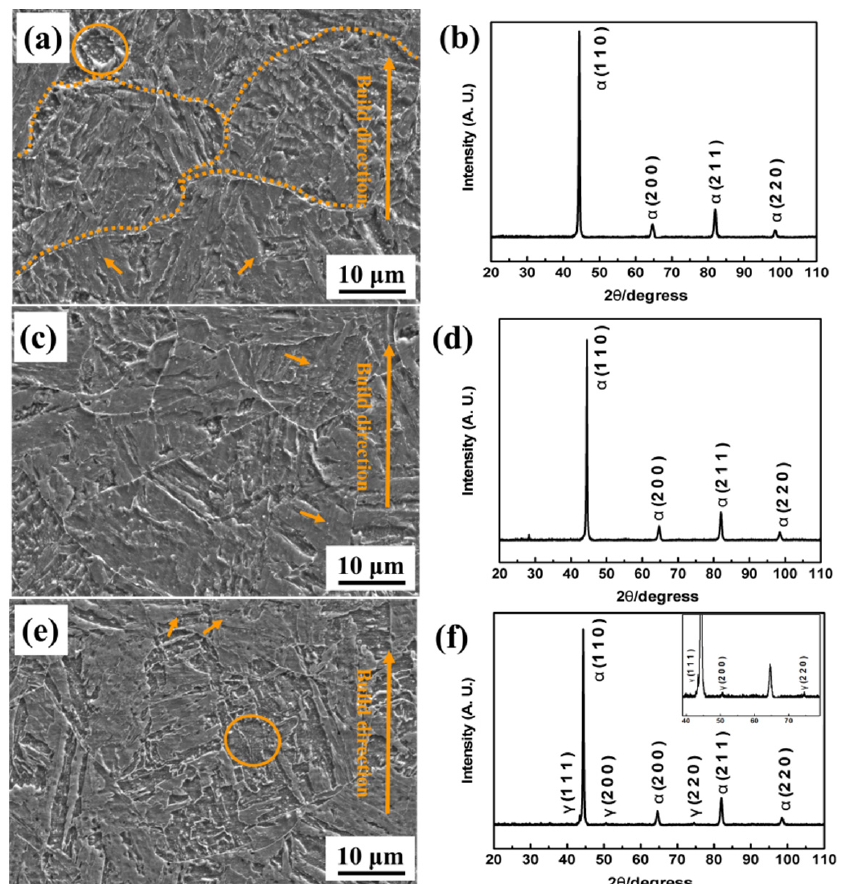
Figure 4. SEM images of the morphology of 17-4PH high-strength steel: ( a ) heat-treated in solution at 1040 °C; ( c ) heat-treated in solution at 1090 °C; ( e ) heat-treated in solution at 1140 °C. XRD patterns of 17-4PH high-strength steel: ( b ) heat-treated in solution at 1040 °C; ( d ) heat-treated in solution at 1090 °C; ( f ) heat-treated in solution at 1140 °C.